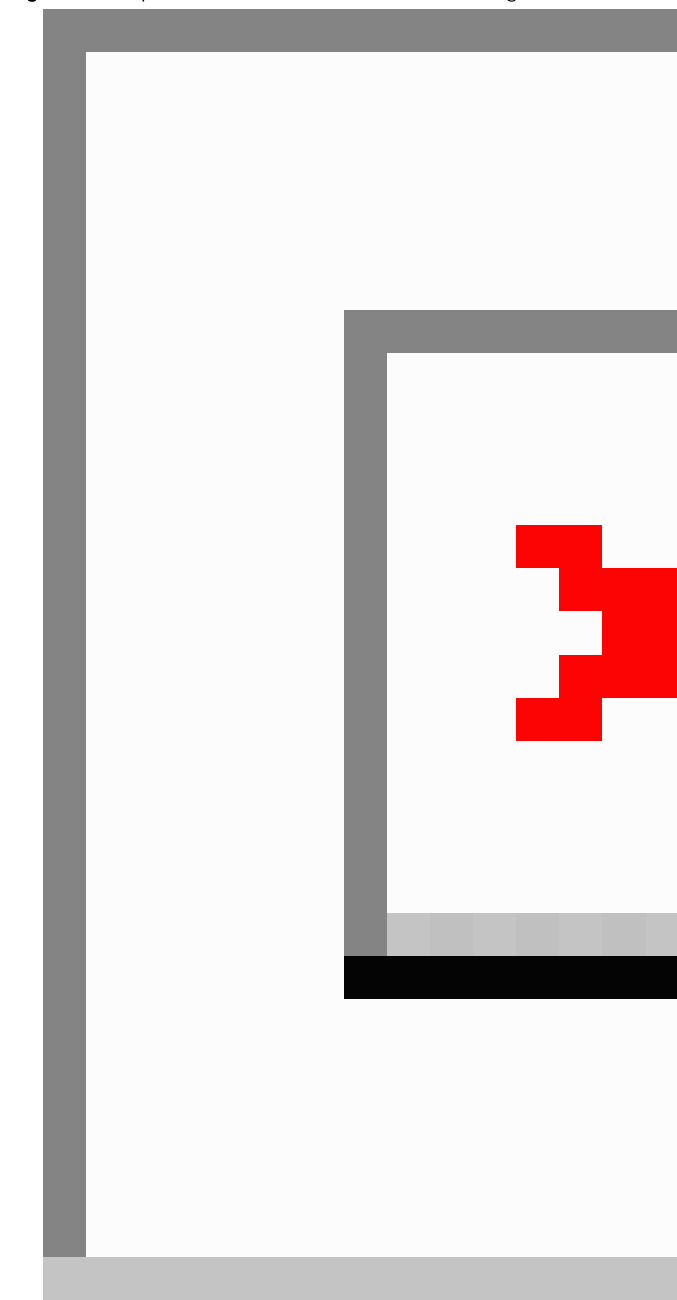
Figure 5. Computational benefits of selective KP